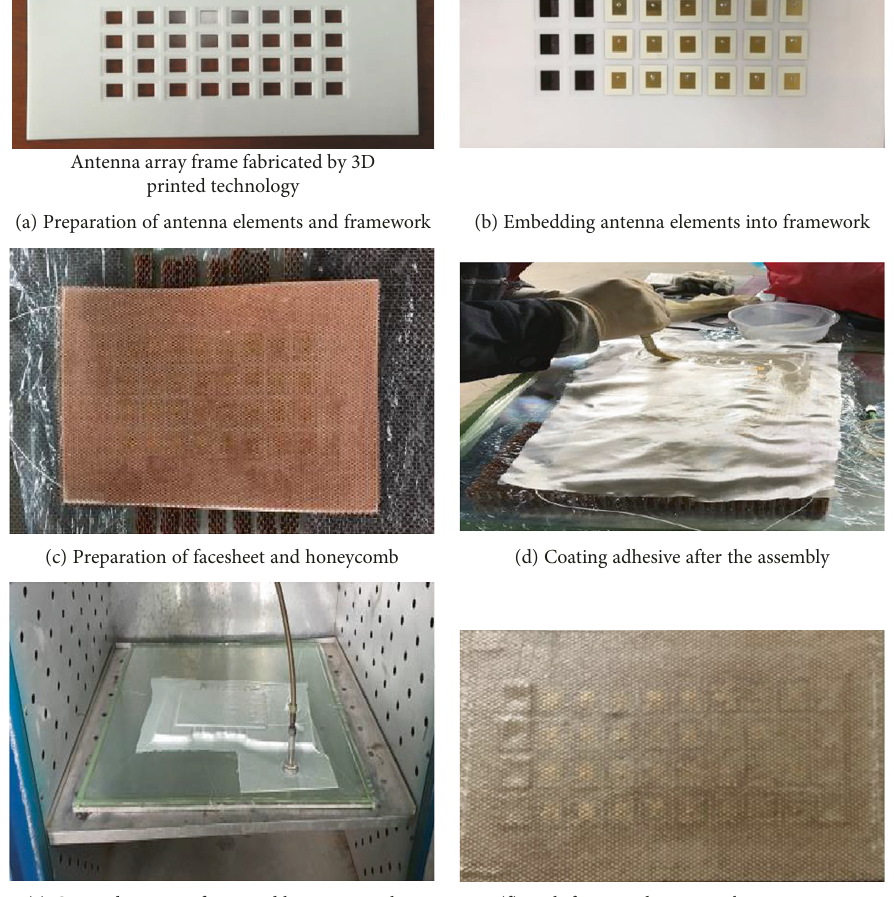
Figure 13: Fabrication process of antenna skin.